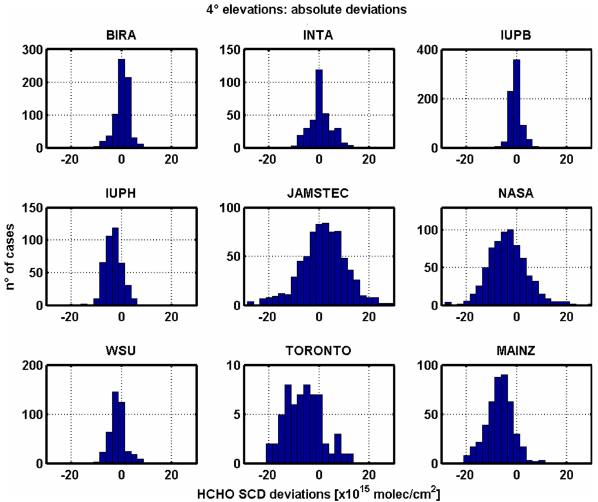
Fig. 8. Histograms of the HCHO DSCD absolute deviations (10 15 moleccm − 2 ) of each instrument’s data compared to the ref- erence set, for the case of measurements at the 4 ◦ elevation angle, and for the whole